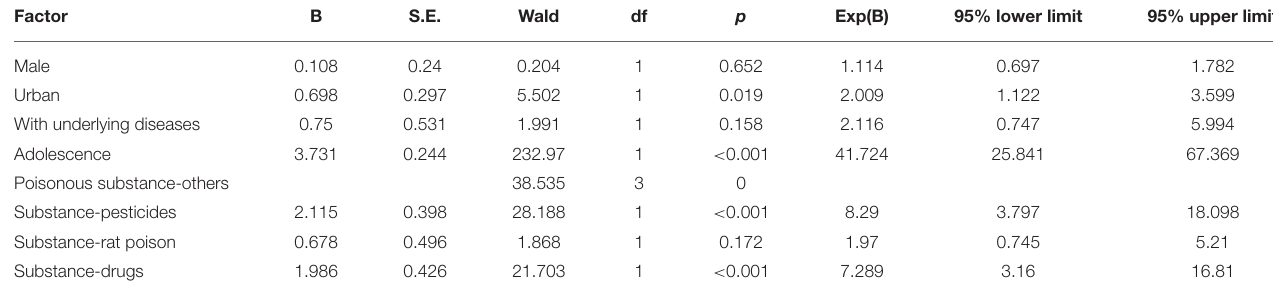
TABLE 5 | Multifactorial analysis of